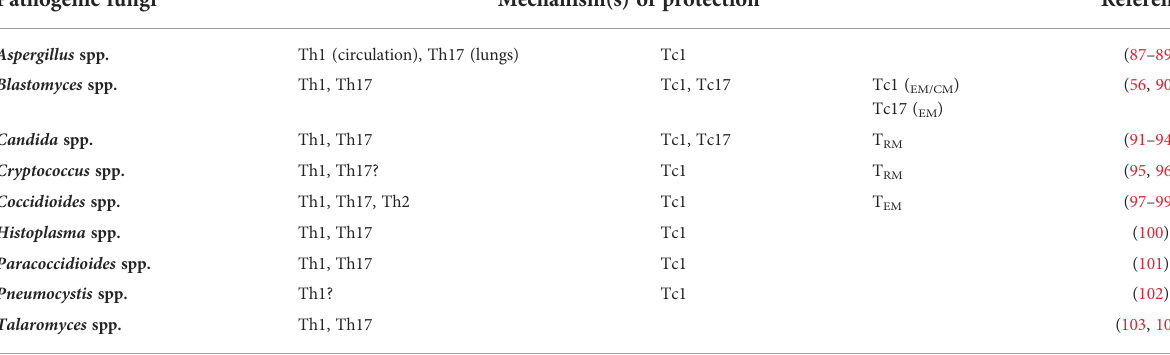
TABLE 1 Major T-cell subsets elicited and shown to be protective against fungal